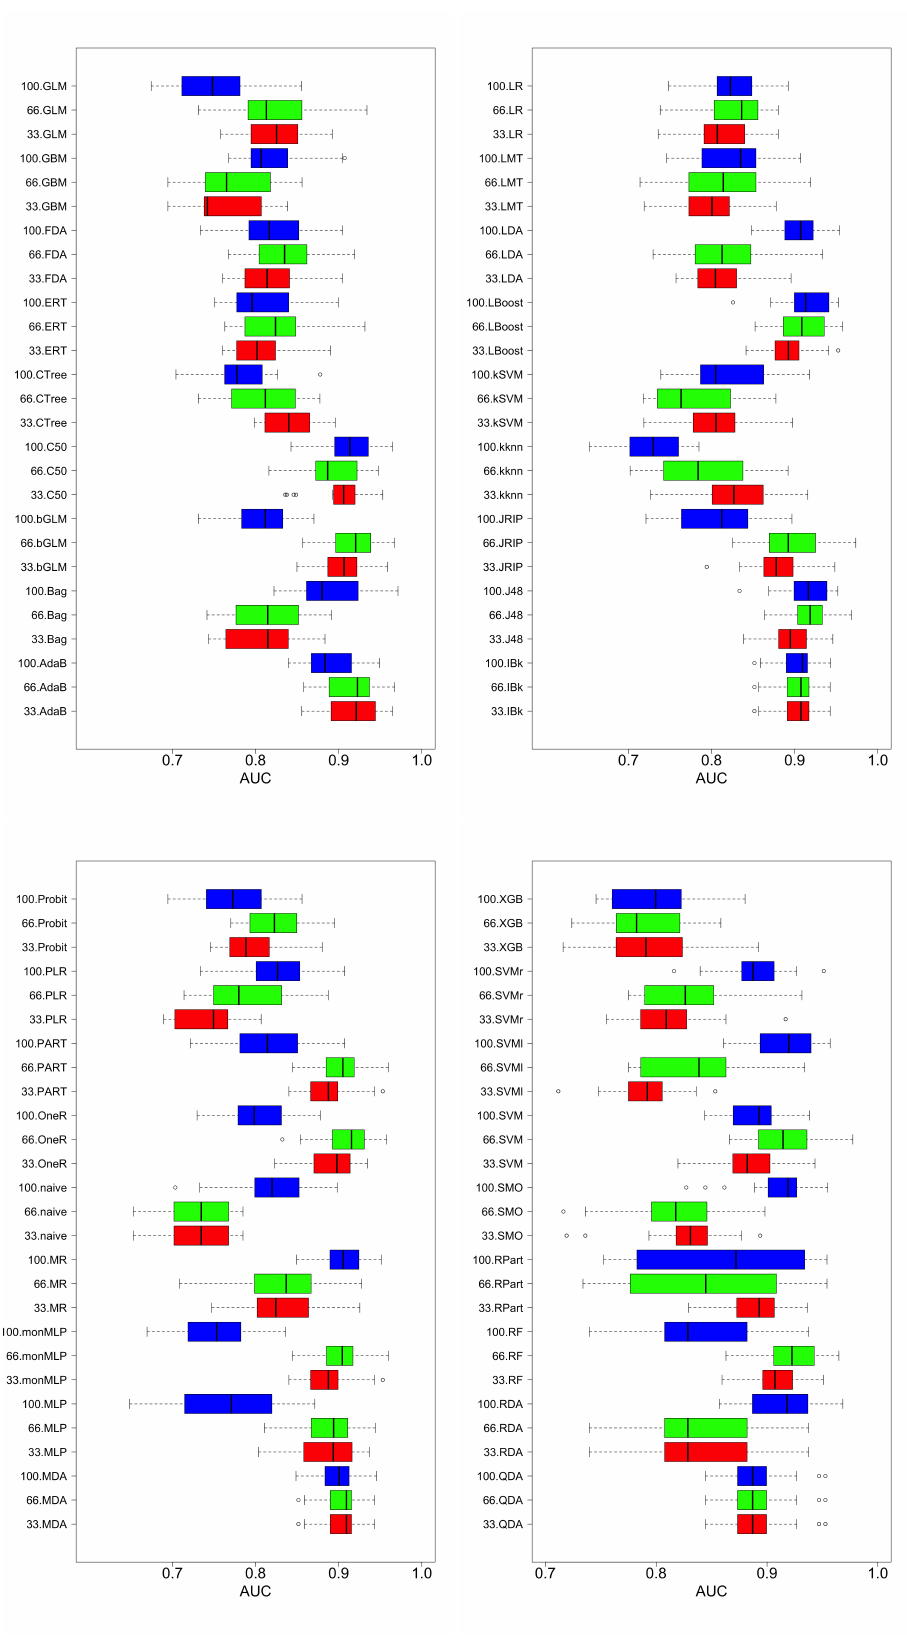
Figure 5. Comparison of classifier performance (AUC). Blue, all features; green, best 66% of features; red, best 33% of